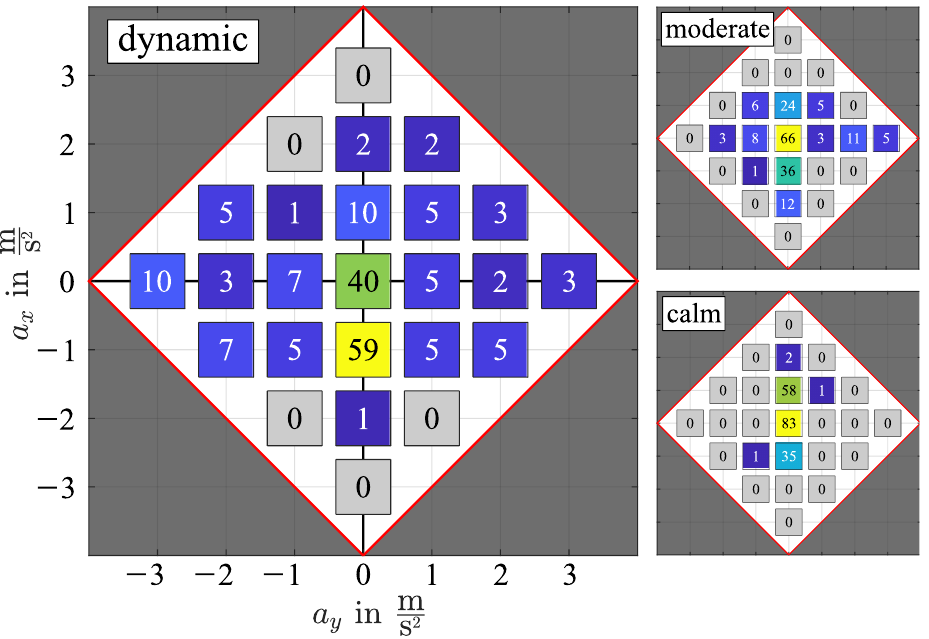
Figure 2. The figure shows examples for the engineered acceleration features in all three driving style